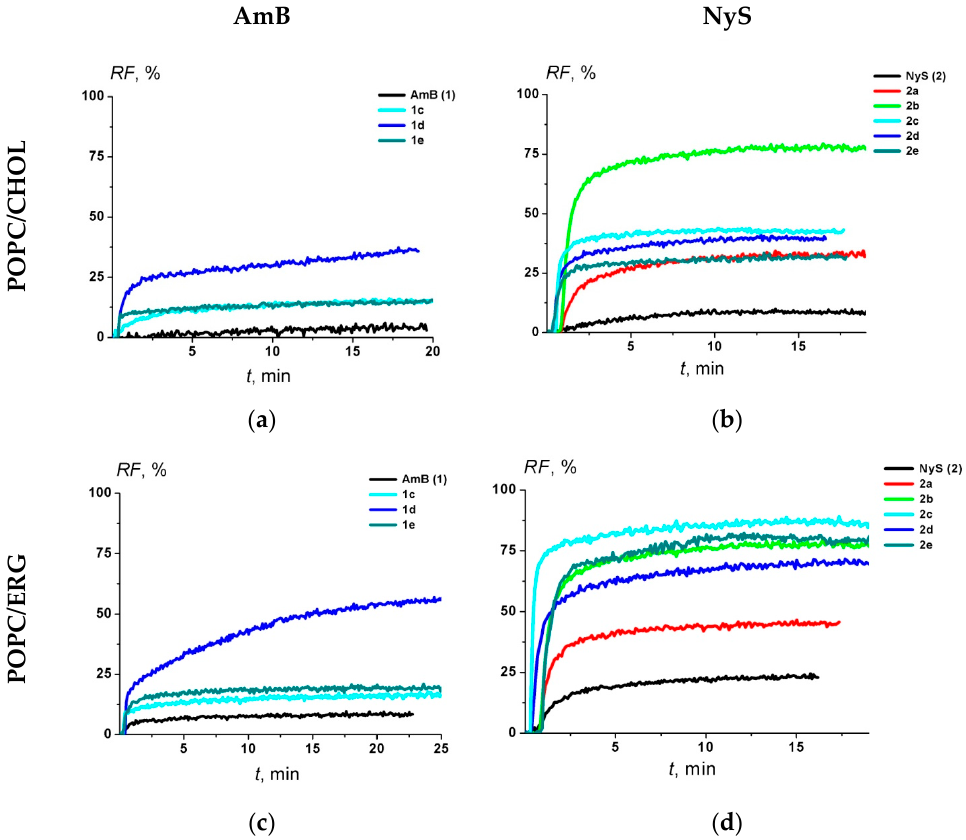
Figure 3. The dependence of the polyene-induced relative fluorescence of calcein (RF, %) leaked from POPC/CHOL (67/33 mol %) (upper panel) and POPC/ERG (67/33 mol %) (lower panel) vesicles on time. The moment of addition of 5 μ M of AmB ( a , c ) and NyS ( b , d ) derivatives into liposomal suspension is referred to as zero point. The relation between the color symbol and the compound is given on the figure. Table 3. The characteristic parameters of the dependence of calcein release from large unilamellar vesicles of indicated composition induced by 5 μ M of antibiotic on time.